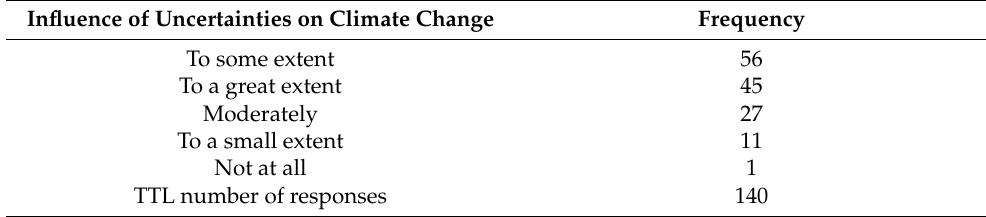
Table 4. Influence of uncertainties on climate change